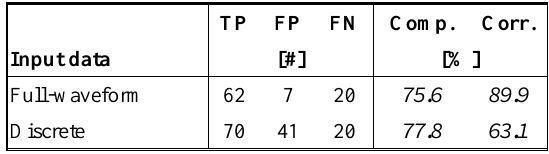
Table 1: Results of the validation. Comparison of full- waveform and discrete data